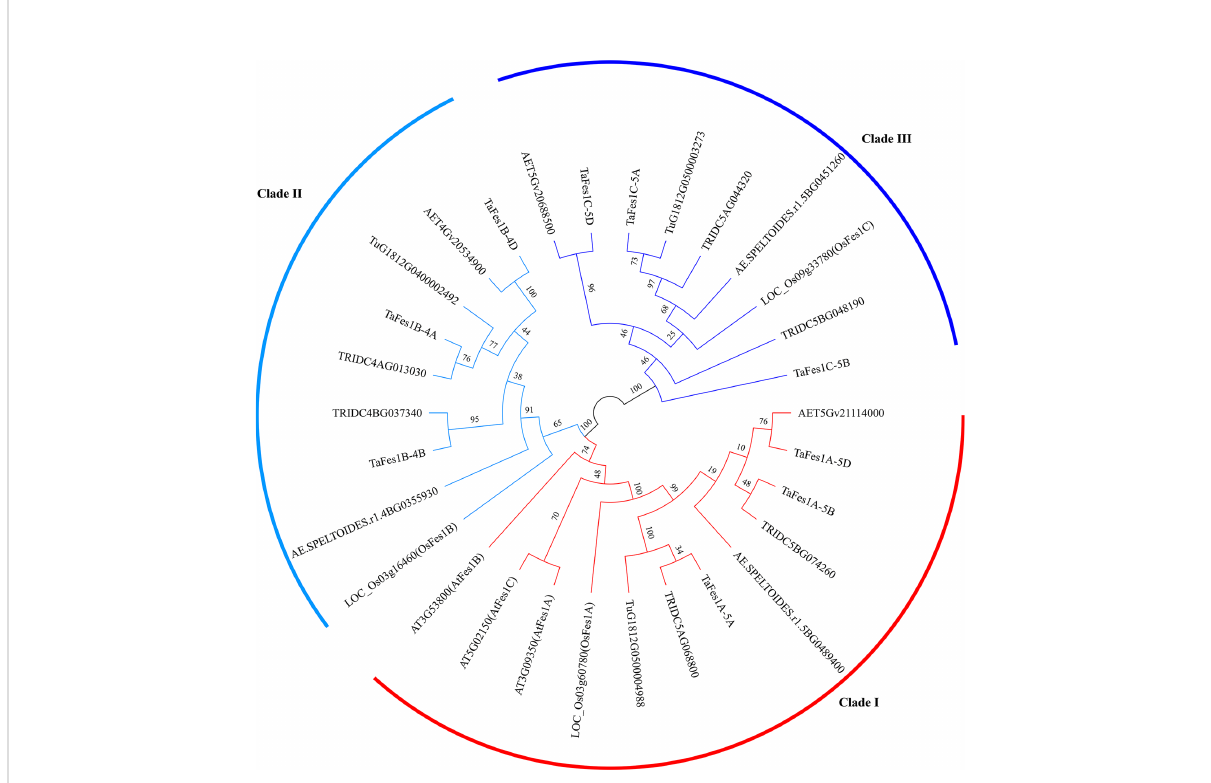
FIGURE 1 Phylogenetic relationship of Fes1s in hexaploid wheat and its progenitors. The maximum likelihood tree is constructed by IQ-tree software and evaluated by 1000 bootstrap replicates. Numbers near branches represent the percentage of 1000 bootstrap values. Different clades of Fes1s are represent by different colors. Species names are embedded in the Fes1s geneIDs: AET, Ae. tauschii ; Tu, T. urartu ; AE.SPELTOIDES, Ae. speltoides ; TRIDC, T. turgidum ssp. Dicoccoides ; Ta, T. aestivum ; LOC, Oryza sativa ssp. Japonica ; AT, Arabidopsis thaliana